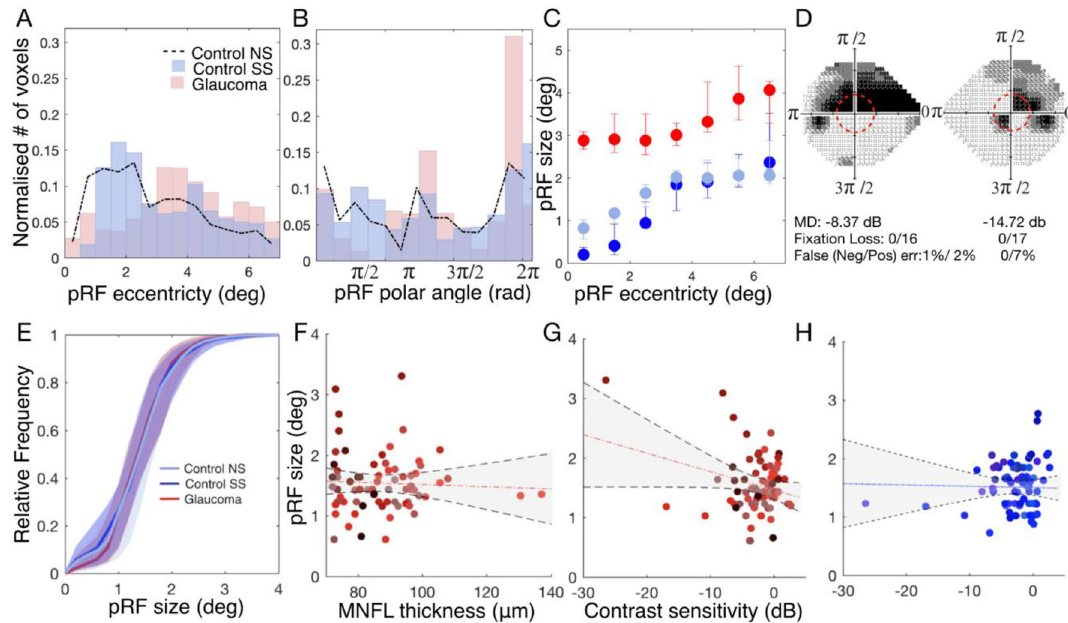
Figure 3. V1 pRF size for participants with glaucoma and control participants. Top row: Example of single participant data: V1 pRF properties differ between participants G01 and C01. ( A , B ) Histogram of the normalized number of responsive voxels, those whose VE > 15%, as a function of eccentricity and polar angle, respectively. The glaucoma participant (G01) is depicted in red and the control participant (C01) in the simulation condition in blue (SS; simulation matched to G01). The control participant’s results in the no simulation (NS) condition are depicted by the dashed black line. ( C ) PRF size as a function of eccentricity for the participant with glaucoma (red) and the control participant in the conditions NS (light blue) and SS (dark blue). The error bars correspond to the 95% confidence interval. ( D ) VFs for the left and right eye. Bottom row: Group level analysis. ( E ) Mean cumulative distributions of pRF size in V1 for the glaucoma participants (red) and the control participants (NS: light blue, SS: dark blue). ( F , G ) V1 pRF size obtained for the glaucoma participants as a function of contrast sensitivity and MNFL, respectively. Data are shown per VF quadrant. Different colors denote the different participants. The dashed red line depicts the linear fit while the black dotted lines and shaded areas correspond to the 95% CIs. ( H ) is a similar plot as ( G ) but for the control participants (SS